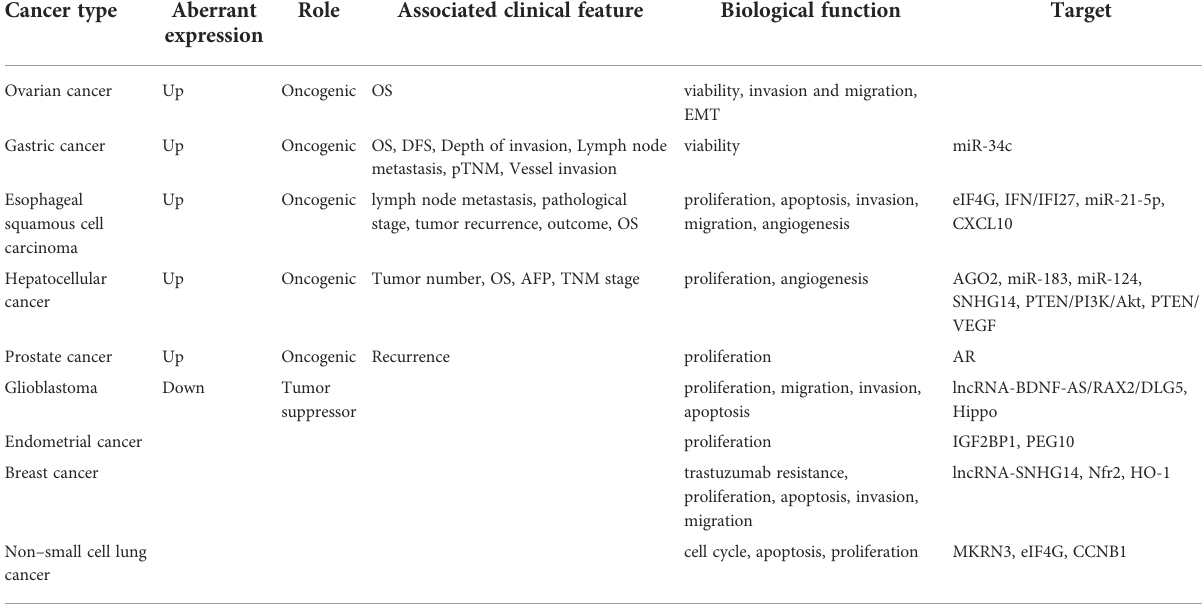
TABLE 2 The expression and role of PABPC1 in multiple